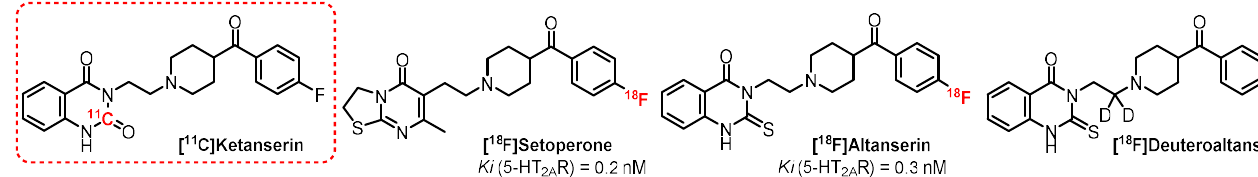
Figure 6. Ketanserin analogues as 5-HT 2A R radiotracers.